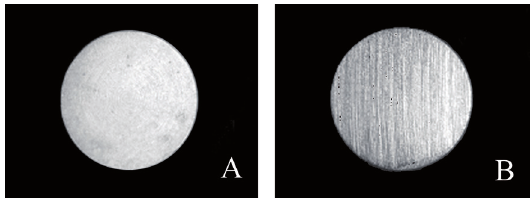
Figure 7: Morphology (Optical Microscopy) of the surfaces before (A) and after (B) the pin-on-disk wear test.